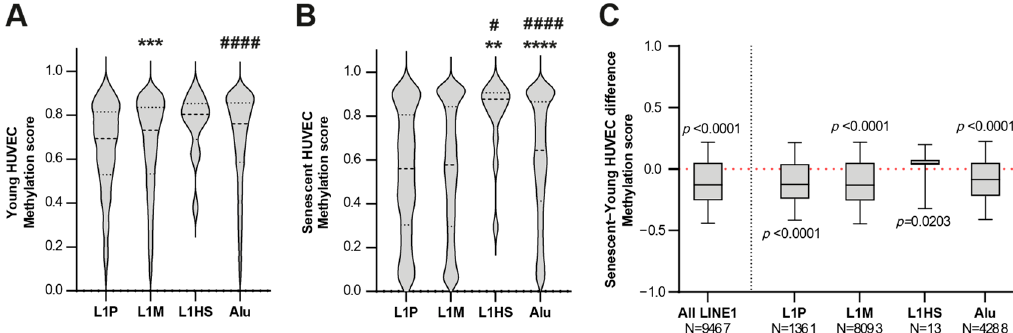
Figure 2. Methylation score of LINE subfamilies and Alu. ( A , B ) Violin plots showing the methylation score of the three LINE subfamilies and Alu in ( A ) young and ( B ) senescent HUVECs. ** p < 0.01; *** p < 0.001; **** p < 0.0001 vs. L1P. # p < 0.05; #### p < 0.0001 vs. L1M for two-tailed unpaired t-test. ( C ) Boxplots showing the distribution of differences in the methylation scores of the LINE1 family, subfamilies, and Alu between senescent and young HUVECs. p for Wilcoxon signed- rank tests.